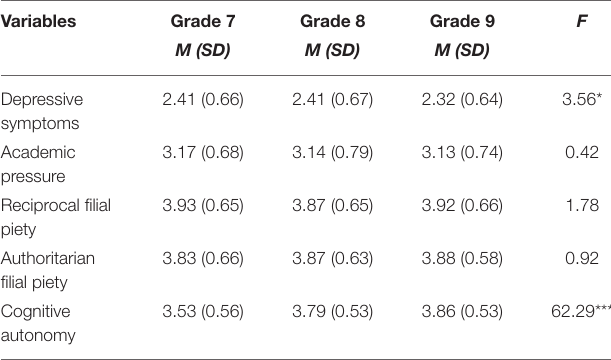
TABLE 1 | The development of adolescents’ depressive symptoms and its predictors.